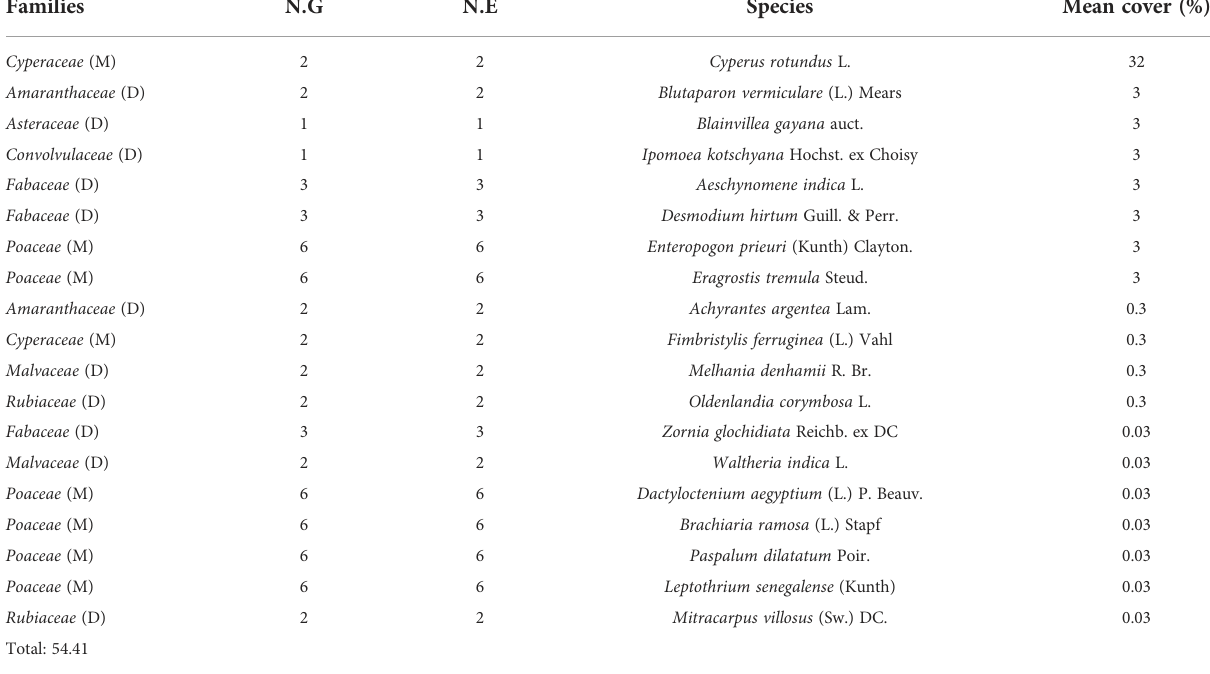
TABLE 7 Percentages of the coverage of herbaceous species beneath Prosopis chilensis . Families